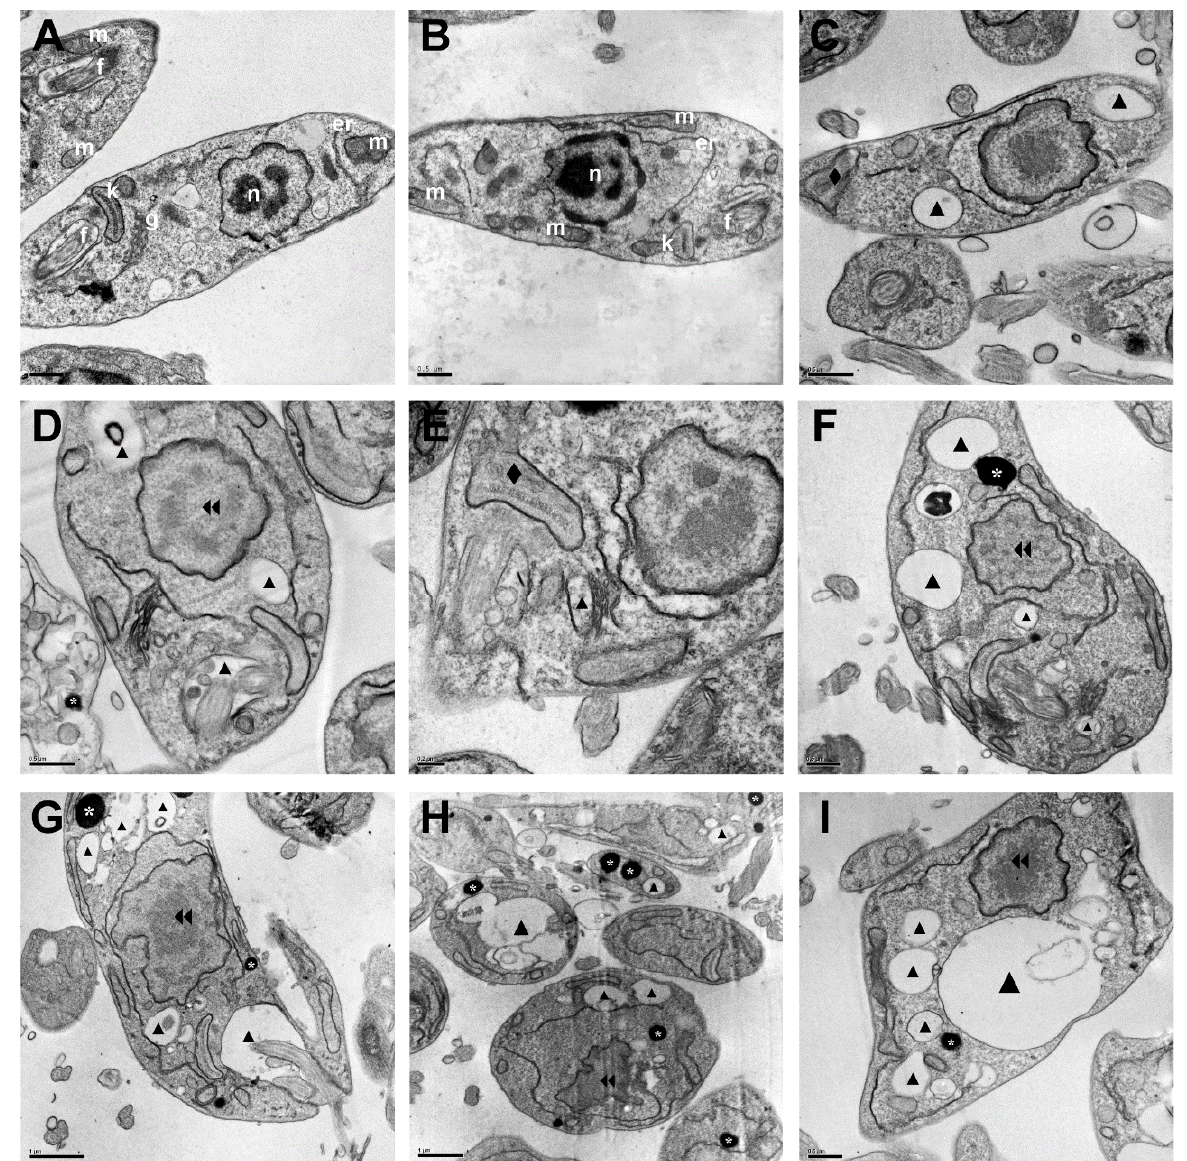
Figure 7. Ultrastructural alterations in promastigotes of Leishmania amazonensis treated with IC 50 3.3 μ M and 2× IC 50 6.6 μ M of 4f for 24 h, analyzed by transmission electron microscopy (TEM). ( A ) untreated promastigotes, ( B ) promastigotes treated with vehicle (DMSO 0.01%), ( C – F ) promastigotes treated with IC 50 3.3 μ M of 4f , ( G – I ) promastigotes treated with 2× IC 50 6.6 μ M of 4f . (er) endoplasmic reticulum, (f) flagellum, (g) Golgi apparatus, (k) kinetoplast, (m) mitochondria, (n) nucleus, ( ▲ ) autophagic vacuoles, (*) lipid-storage bodies, ( ◆ ) mitochondrial swelling, ( ▶▶ ) nuclear alterations. Scale bars = 1 μ m ( G , H ), 0.5 μ m ( A – D , F , I ) and 0.2 μ m ( E ).